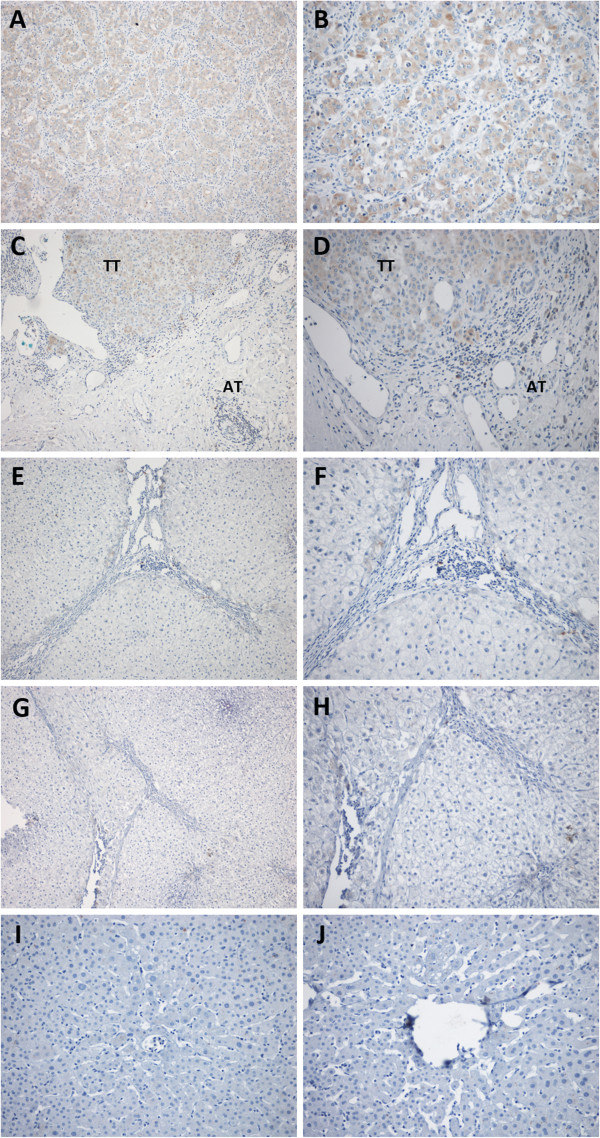
Distribution of GGPPS1 antigen in liver tissues and tumor tissues of the patients with hepatocellular carcinoma. The representative images are shown from tumor tissues (TT, A and B), adjacent non-tumor tissues (AT, C and D), tumor free tissues (TF, E and F), cirrhotic controls (CC, G and H), healthy controls (HC, I and J) tissues. Magnification: A, C, E, G, I 100×, B, D, F, H, and J 200 ×.